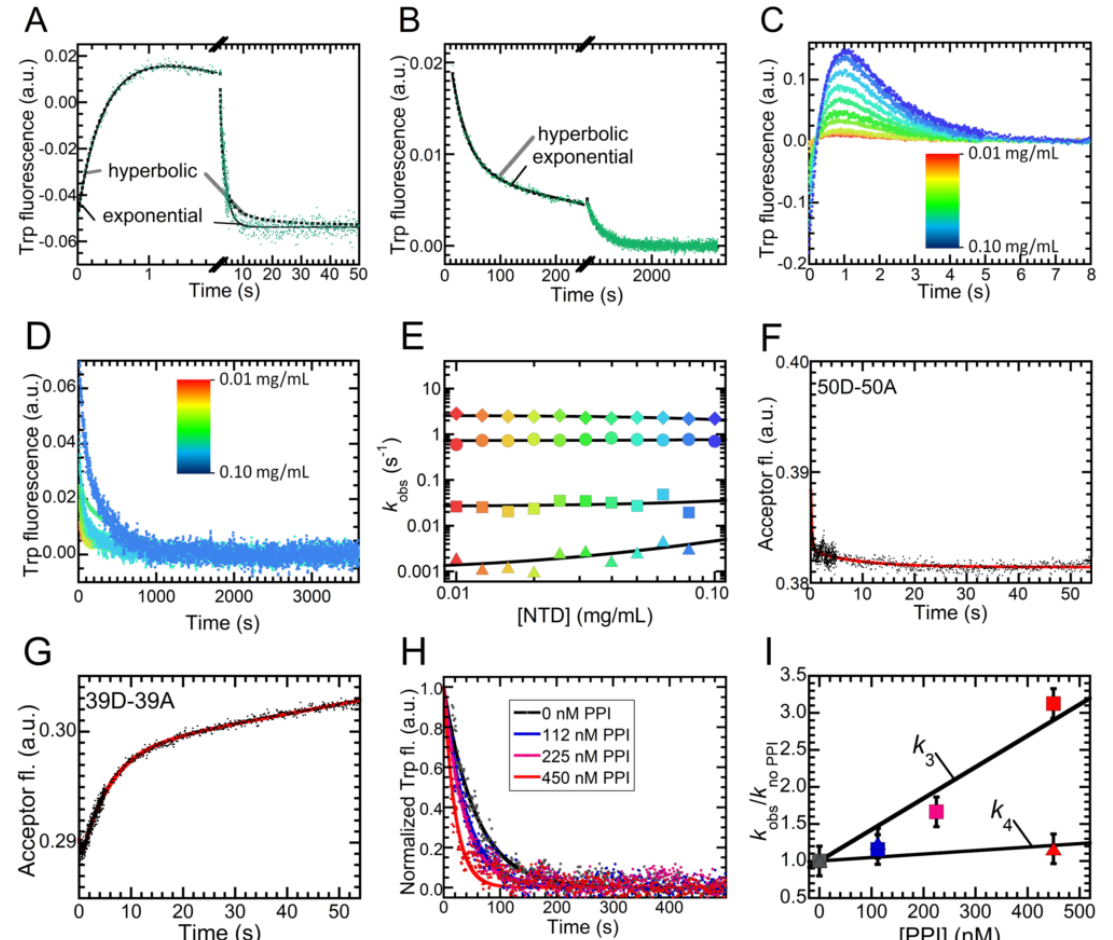
Figure 6. Insight into the NTD refolding process. ( A , B ) Comparison between the best fits to a hyperbolic (dashed line) and an exponential (continuous line) equation of one refolding trace measured in 1.2 M urea ( A ) and in 1.6 M urea ( B ). Time scales are suitable to observe the first and second ( A ) or the third and fourth ( B ) phases. In both panels, axis breaks separate the two investigated phases. ( C,D ) Analysis of NTD refolding as a function of protein concentration. Data are shown for the first and second ( C ) or the third and fourth ( D ) refolding phases. In both panels color ranges from red to blue upon NTD concentrations increasing from 0.01 to 0.1 mg / mL (1.16–11.6 µ M). ( E ) Refolding rate constants as a function of NTD concentration for the first (diamonds), second (circles), third (squares) and fourth (triangles) refolding phase, as determined by best fits of experimental data to double exponential equations. ( F , G ) Fluorescence of the 6-IAF acceptor monitored during refolding of a 1:1 molar ratio of NTD labeled with a donor and acceptor at position 50 (50D-50A, panel F ) and 39 (39D-39A, panel G ). Continuous lines represent best fits of experimental data to a double exponential equation. ( H ) Third and fourth phases of refolding recorded at di ff erent PPI concentrations, ranging from 0.00 to 0.45 µ M. Continuous lines represent best fits of experimental data to double exponential equations. ( I ) Ratio between the refolding rate constant measured at a given PPI concentration ( k obs ) for the third and fourth refolding phase and the value measured in the absence of PPI ( k no PPI ). Colors as in panel H .